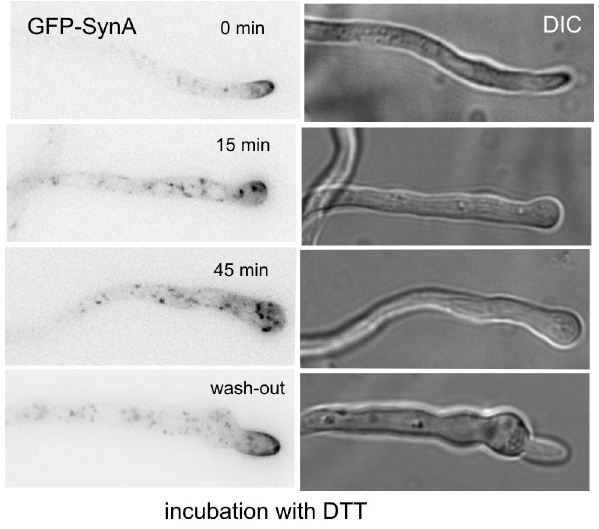
Figure 5. Reductive ER stress results in reversible impairment of exocytosis. GFP-SynA (inverted greyscale) and Nomarski (DIC) images of hyphal tips of cells incubated with DTT for the indicated times. The wash-out tip example corresponds to a DTT-treated cell further incubated in medium lacking the reducing agent.